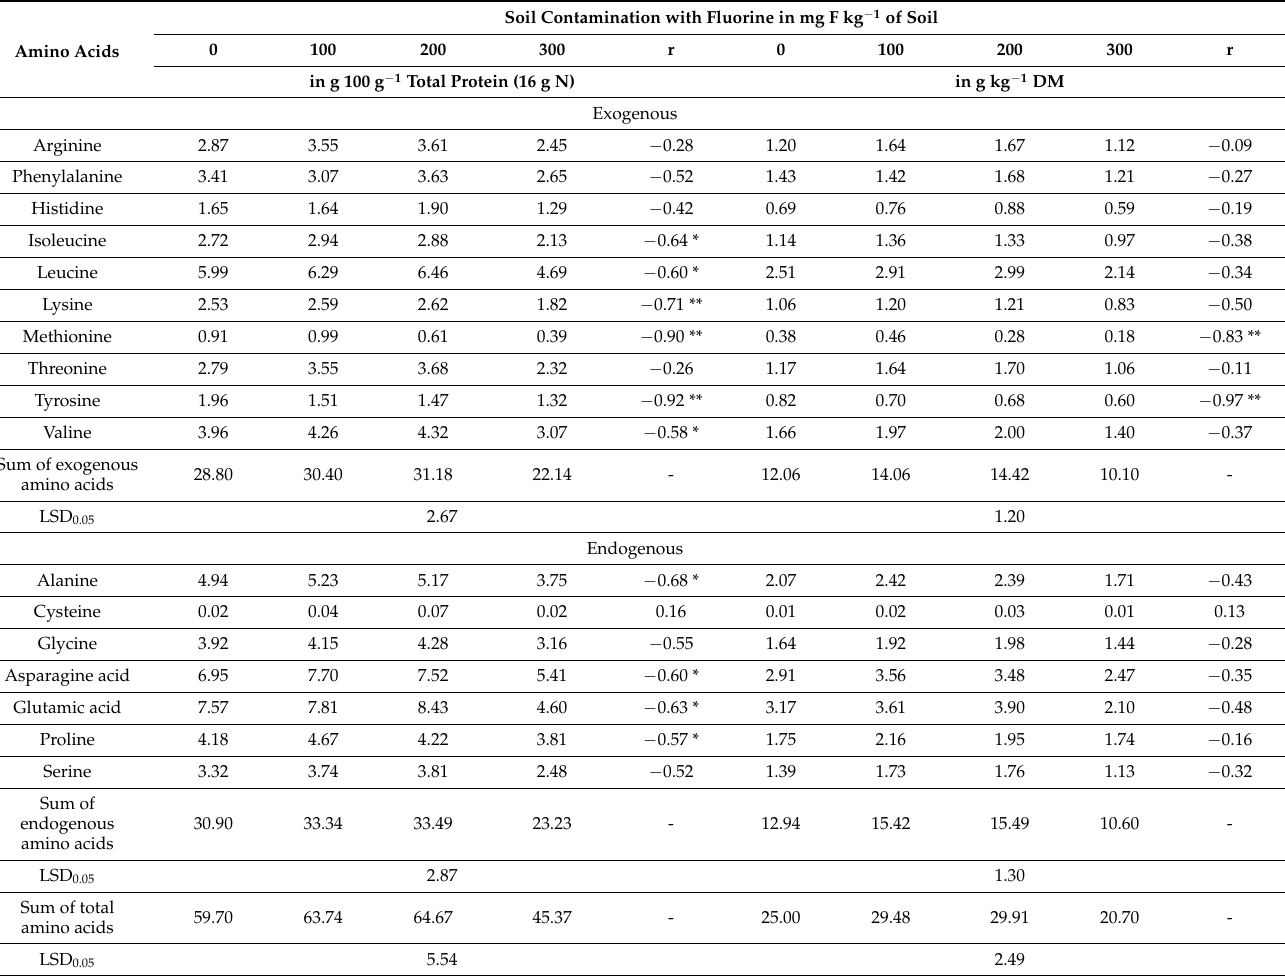
Table 1. Influence of fluorine application to soil on the amino acid content in aerial mass of